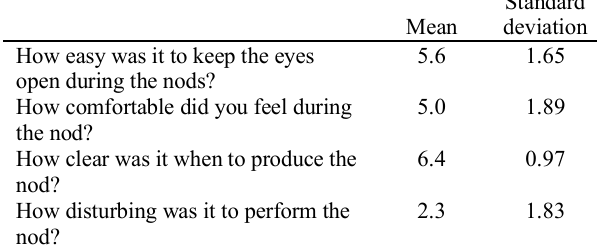
Table 5. Rating results of participants’ subjective experiences. A 7-step scale (1=not at all – 7=very much, reversed for last ques- tion) was